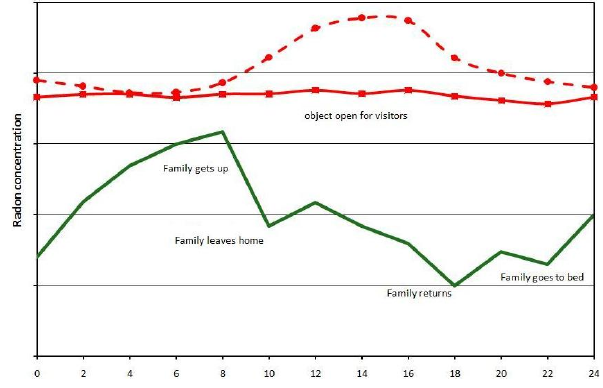
Fig. 6. Fig. 6. Daily pattern of 222 Rn activity concentration for three se- lected characteristic days, representing three seasons in a year, dif- fering in values and variation in radon concentration in Fluorite Adit in Kletno.